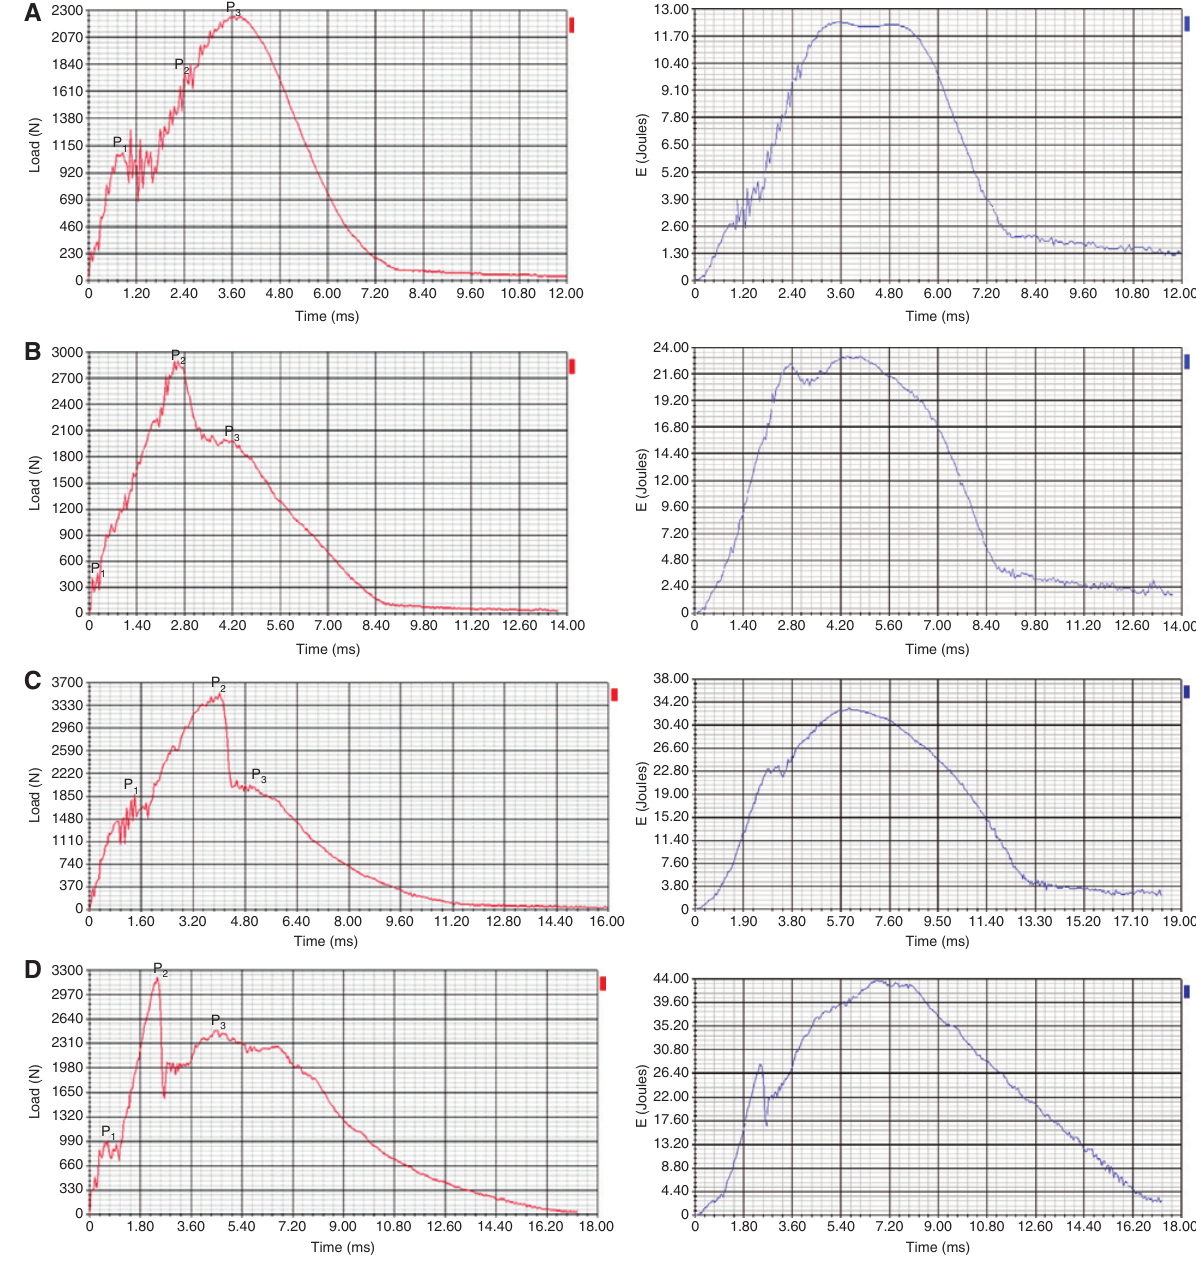
Figure 6 Load-time and energy-time plot for C20 panel at different impact energy levels. (A) Impact energy -12.64 J, (B) impact energy -25.27 J, (C) impact energy -37.64 J, (D) impact energy -50.19